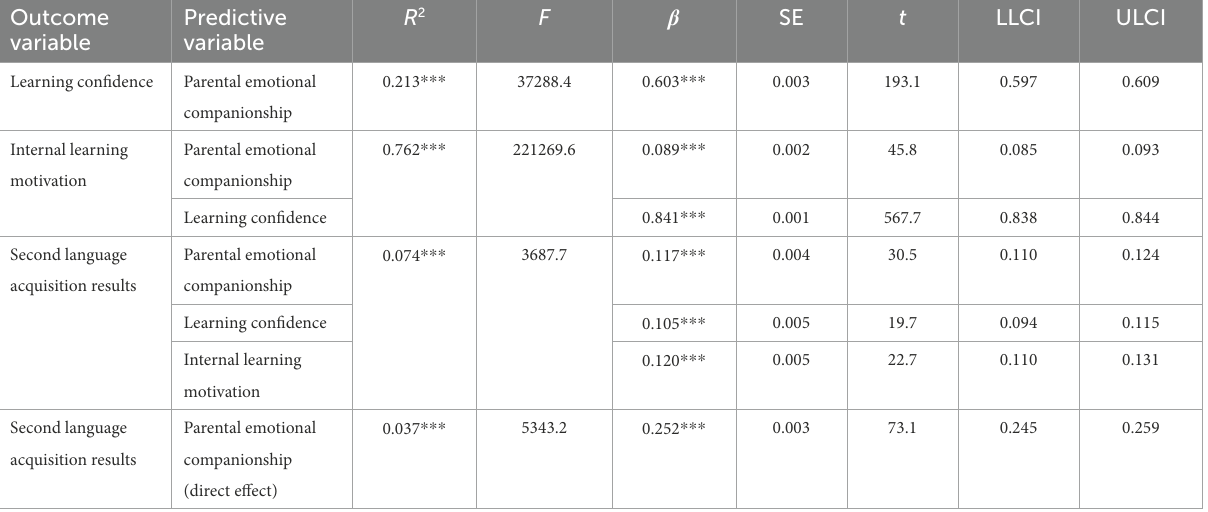
TABLE 3 Regression results of variables in primary school group.